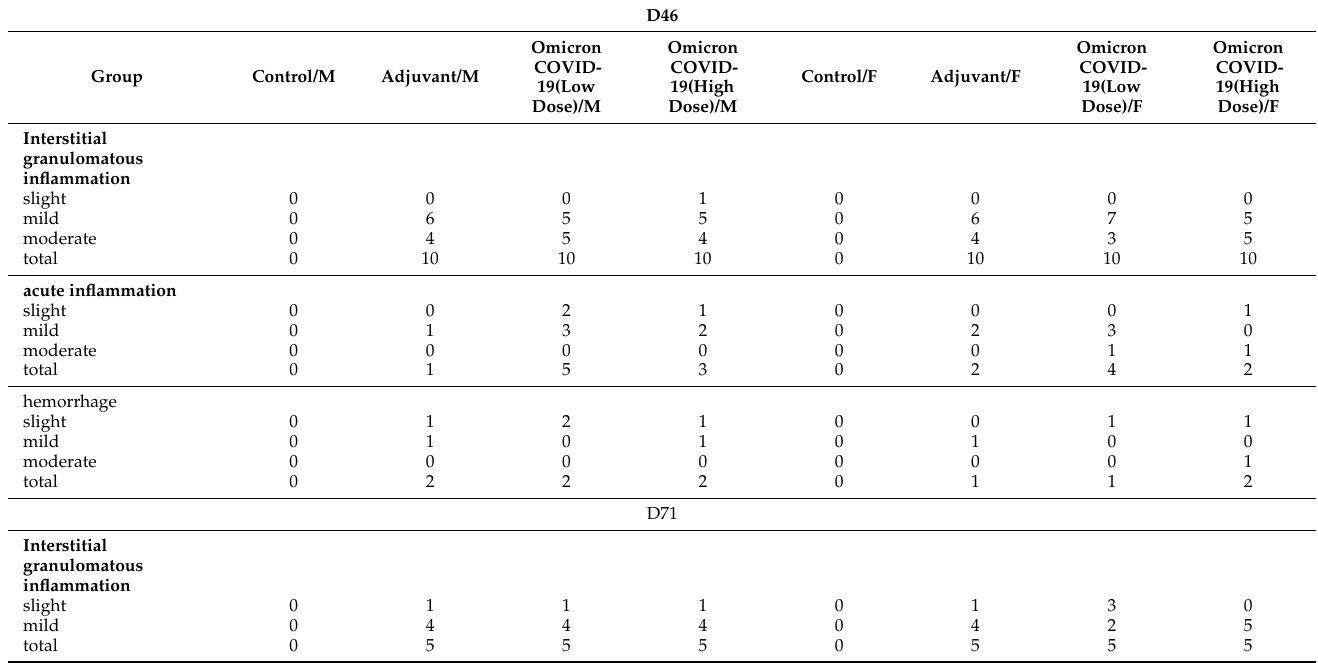
Table 5. Summary of histopathological changes at the site of injection in different groups.